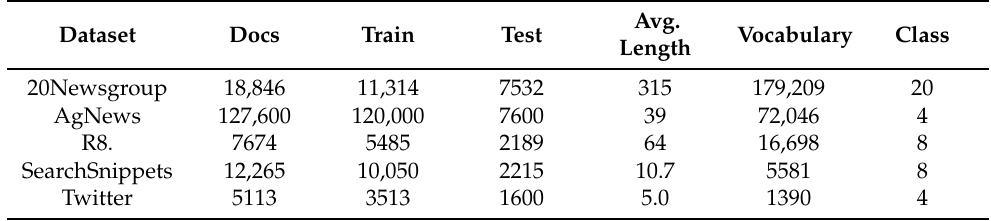
Table 1. Statistics of short text